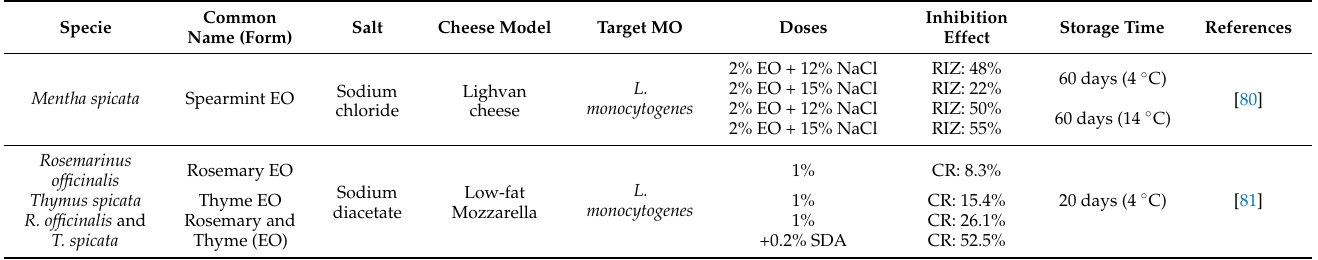
Table 3. Synergism between essential oils and sodium salts for extending the shelf life of cheese. Cheese